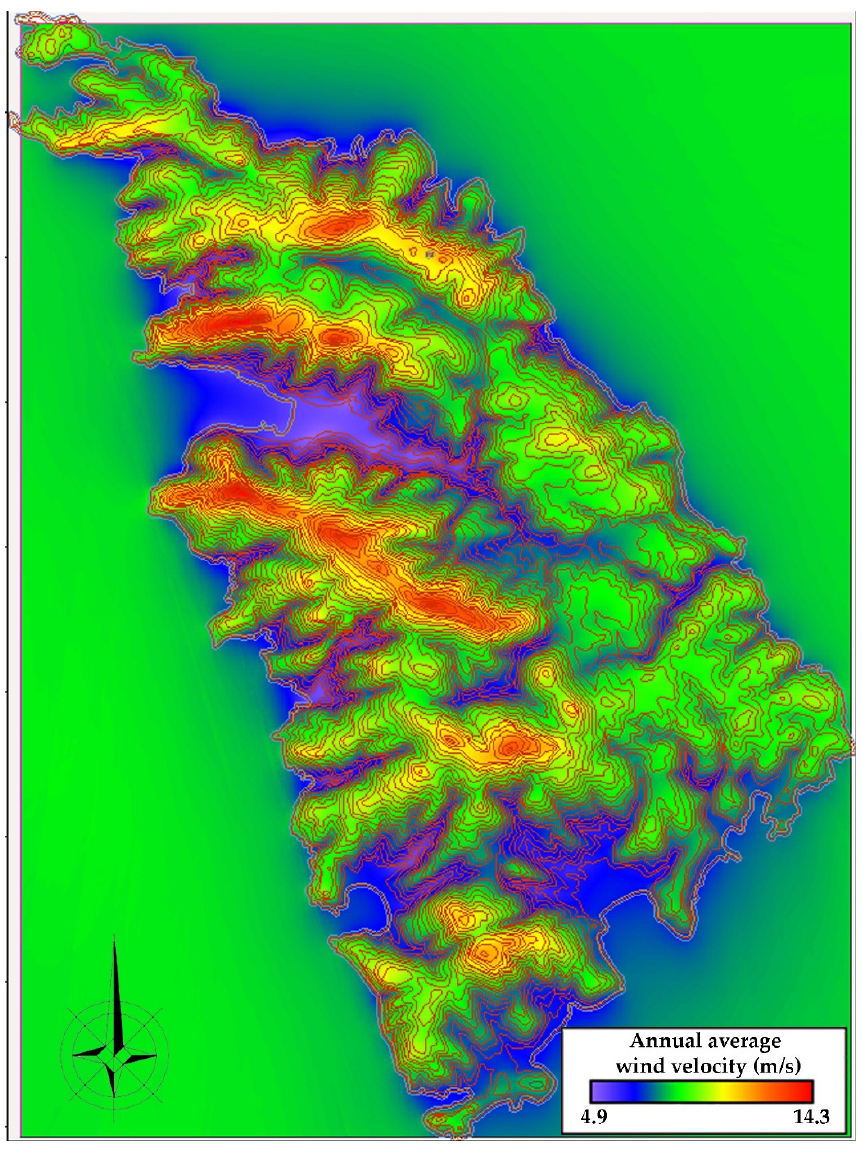
Figure 3. Annual average wind velocity map for the island of Sifnos.